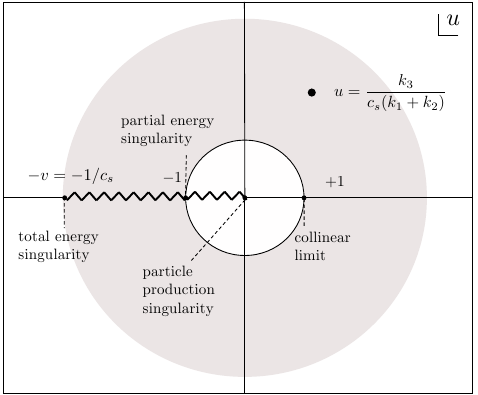
ˆ Figure 7 . The analytical structure of F ++ as a function of complex u . Motivated by the fact that in the bispectra formulae (3.34) we set v = 1 /c , we have taken v to be a positive and bigger than s 1 parameter. Moreover, in contrast with the ordinary case of c = 1 , these equations also imply s that u = k ( k + k ) is allowed to lie outside the unit disk. The shaded region is the annulus 3 /c s 1 2 where the expression (4.21) is valid. There are three branch points, located on the real axis at u = 0 (due to the particle production effect discussed in section 4.5), at u = − 1 (due to the partial energy singularity (3.50)) and finally at u = − v (due to the total energy singularity (3.49)). The four-point function should have no divergence near the collinear limit ( u = 1 ), see section